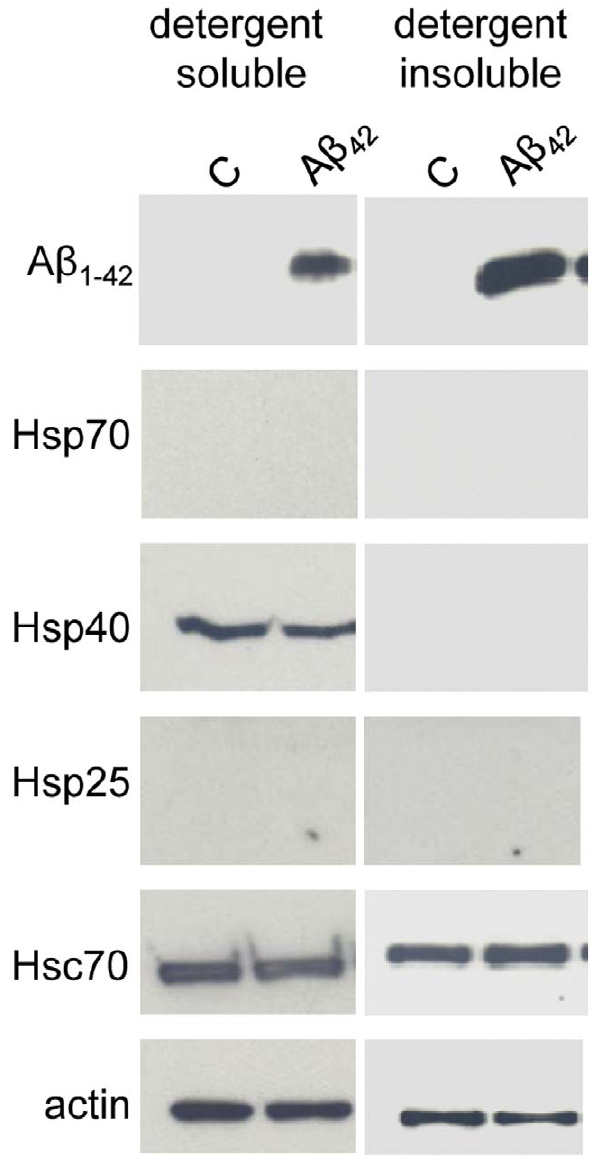
Figure 1. A b 42 does not trigger the heat shock response in CAD neural cells. CAD cells were incubated with 25 m M A b 42 for 48 hours, washed in PBS and lysed. 30 m g of soluble protein or 10 m l of the insoluble fraction were resolved by SDS-PAGE and the indicated proteins were evaluated by Western blot analysis. b -actin is shown as a loading control. Data are representative of 3 separate experiments.